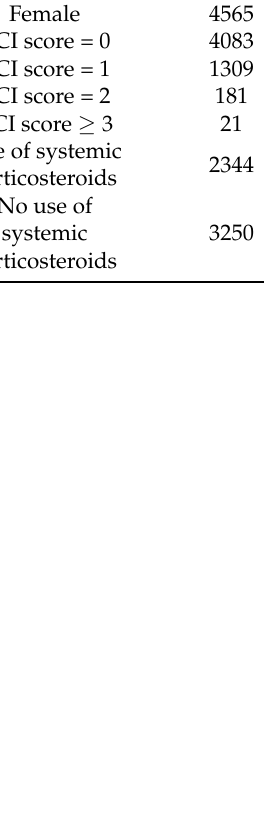
Table 5. Univariate and multivariable analyses for corneal surface